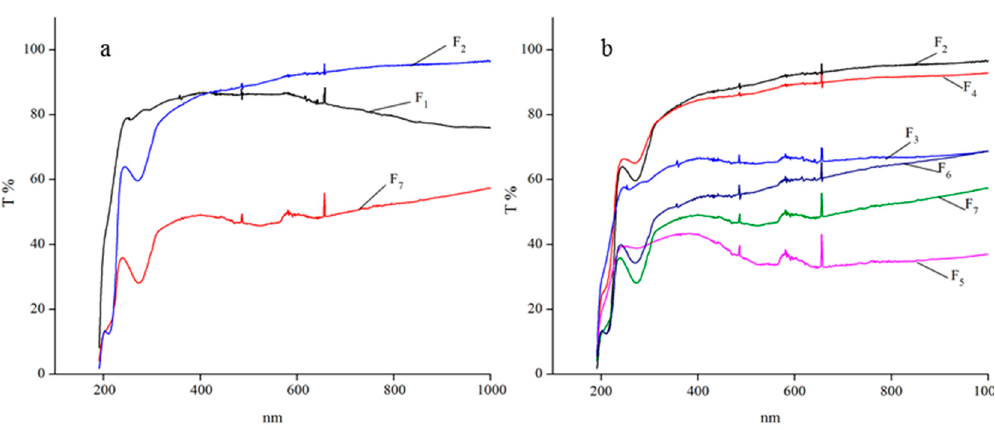
Figure 5. UV-vis spectra of composite films with different DS of XC and CAX. (( a ): F 1 , F 2 ; F 7 ; ( b ): F 2 –F 7 ; F 1 –F 7 respectively representative of the DS: 0, 0.11, 0.18, 0.21, 0.33, 0.46, and 0.57).